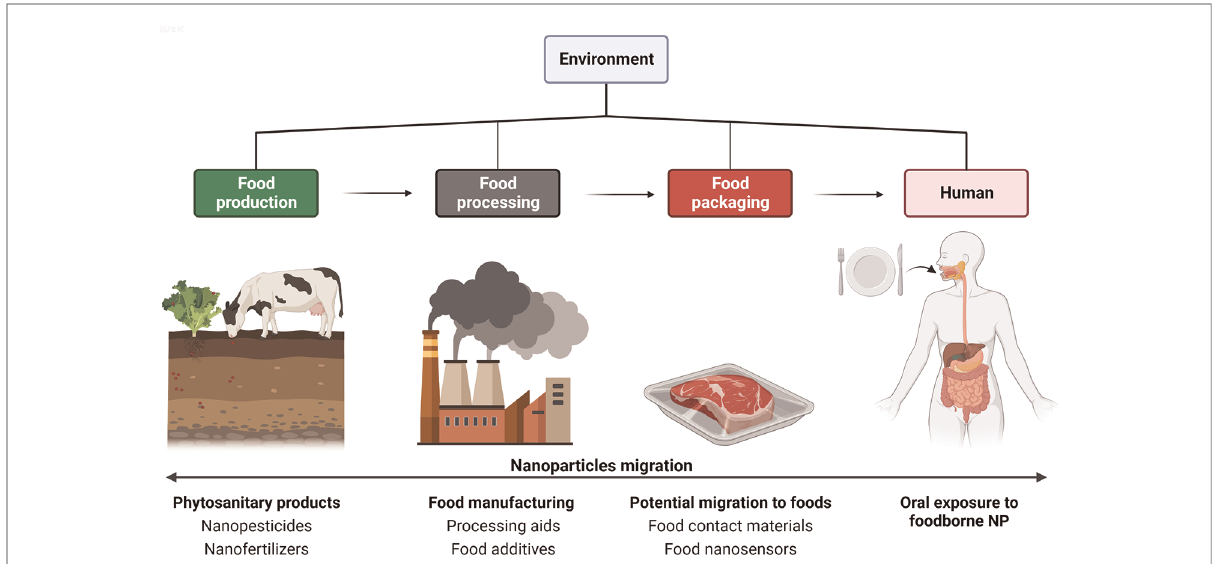
FIGURE 3 Applications of nanomaterials along the food chain. From left to right: Starting with the agricultural sector for food production, which uses nanoparticle (NP)-based formulations for innovative phytosanitary products (nano-sized pesticides, herbicides, fungicides, and fertilizers), second during food manufacturing with nanotechnologies applied from ingredients (food additives), processing aids (anti-caking agents, biocidal agents), until food packaging (new barrier properties for food contact materials, and nanosensors). Most of these applications can lead to chronic oral exposure of consumers through diet (Created with